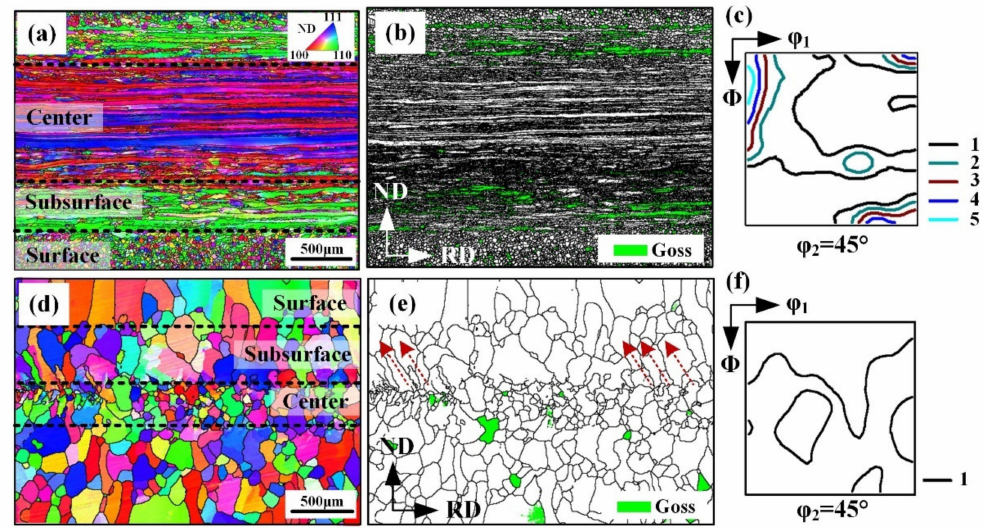
Figure 3. EBSD Orientation image maps ( a , d ) and Goss texture with the deviation of 15 ◦ ( b , e ), as well as ϕ 2 = 45 ◦ sections of ODFs ( c , f ) in the hot rolled ( a – c ) and as-cast strips ( d – f